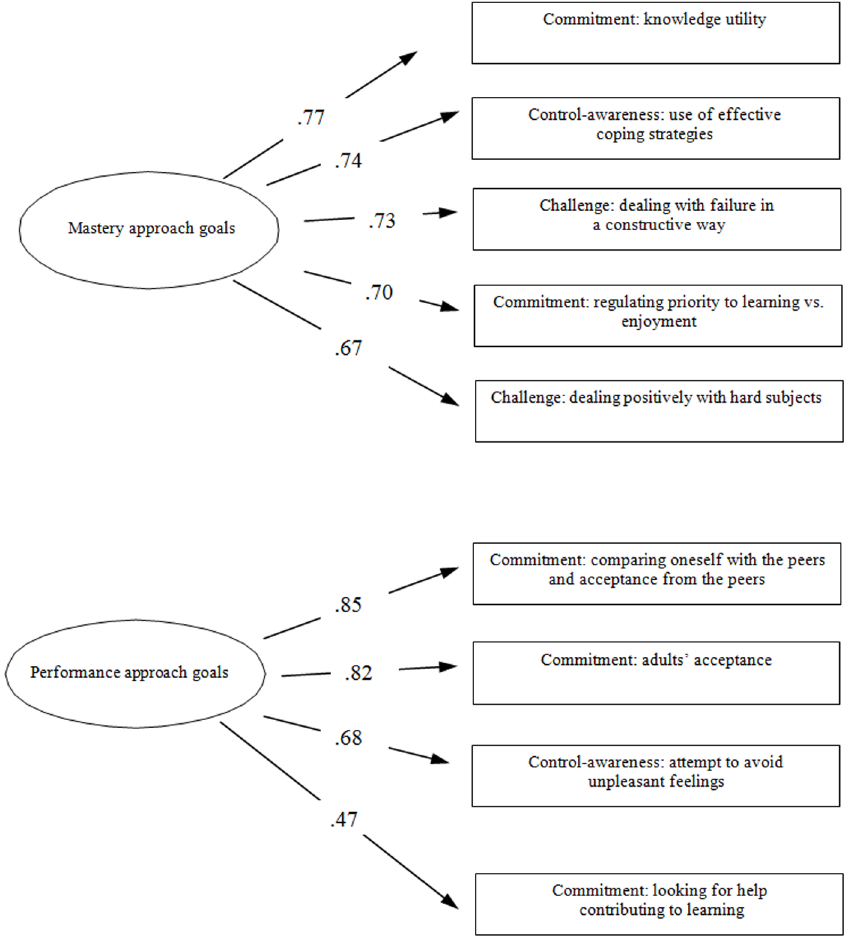
Figure 2. Second order factor analysis